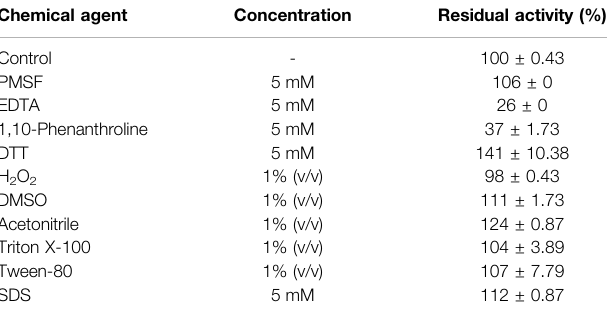
TABLE 2 | Effect of chemical agents on the stability of keratinase from C. aquifrigidense FANN1. Chemical agent